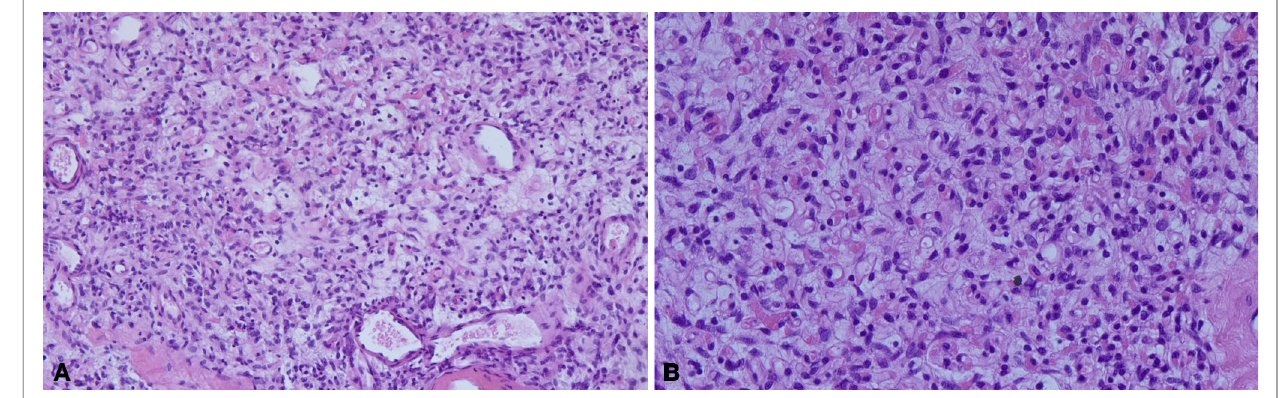
FIGURE 2 | The histopathological examination. Spindle-shaped cells resting in the background of fi brous stroma containing delicate collagen fi bers and numerous small to medium-sized thick-walled blood vessels. ( A ) ×100, ( B ) ×200.